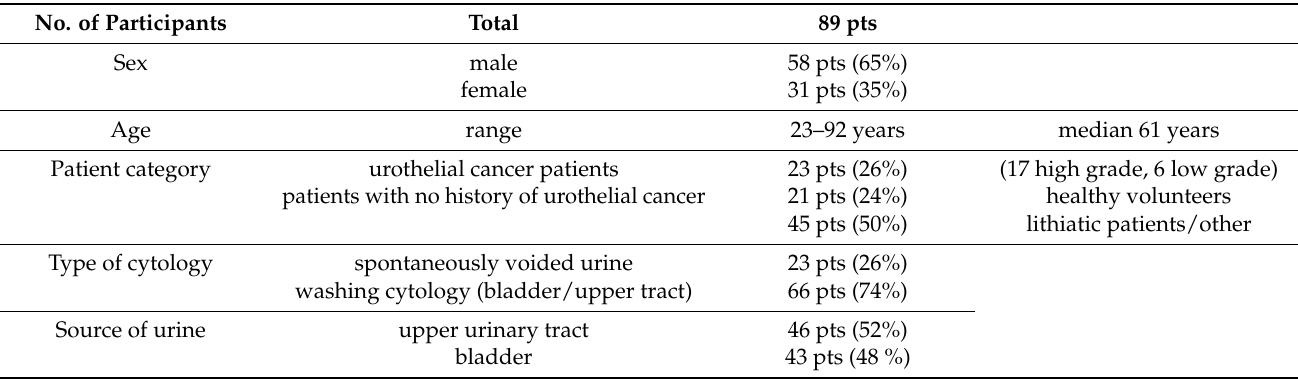
Table 2. Demographic data and patient characteristics.